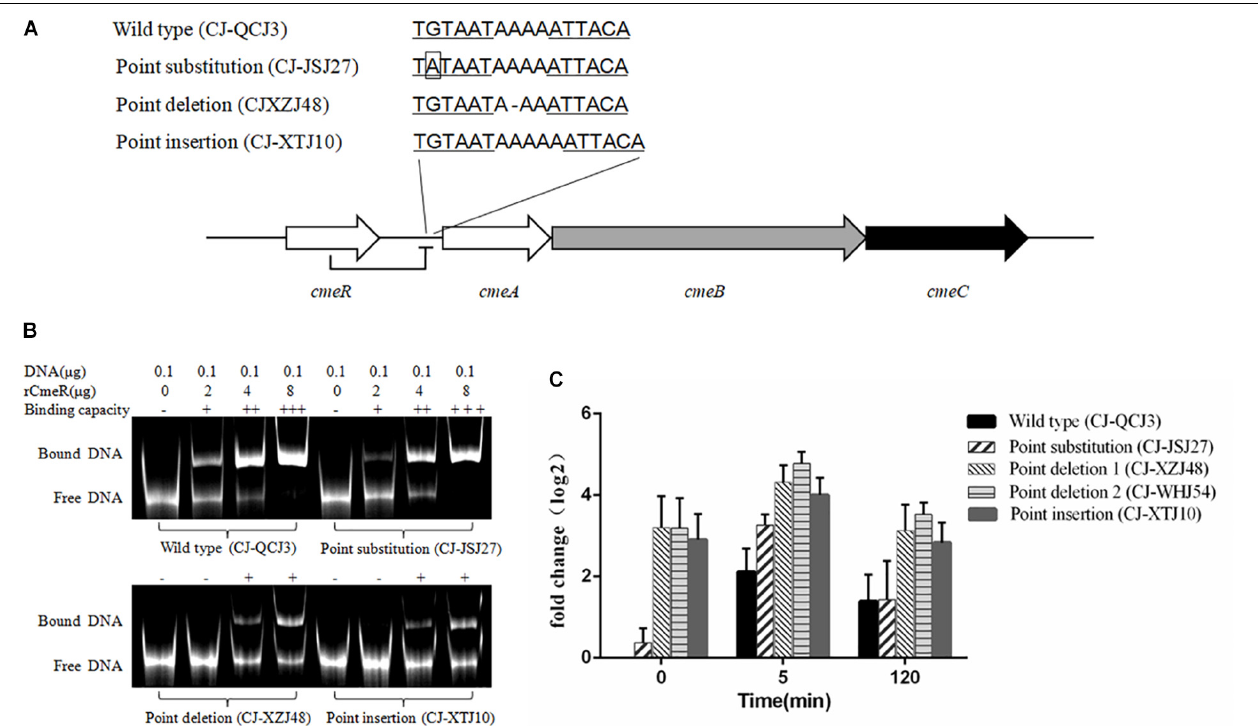
FIGURE 2 | cmeA expression levels in Campylobacter isolates with different CmeR-Box sequences. (A) CmeR-Box sequences in the Campylobacter isolates. (B) Binding of CmeR to the variant cmeABC promoter DNA. (C) The expression levels of cmeA gene at 5- and 120-min post-erythromycin treatment in the Campylobacter isolates harboring different CmeR-Box sequences. Each assay was carried out at least in three biological replicates, and the bars mean the standard deviation in each